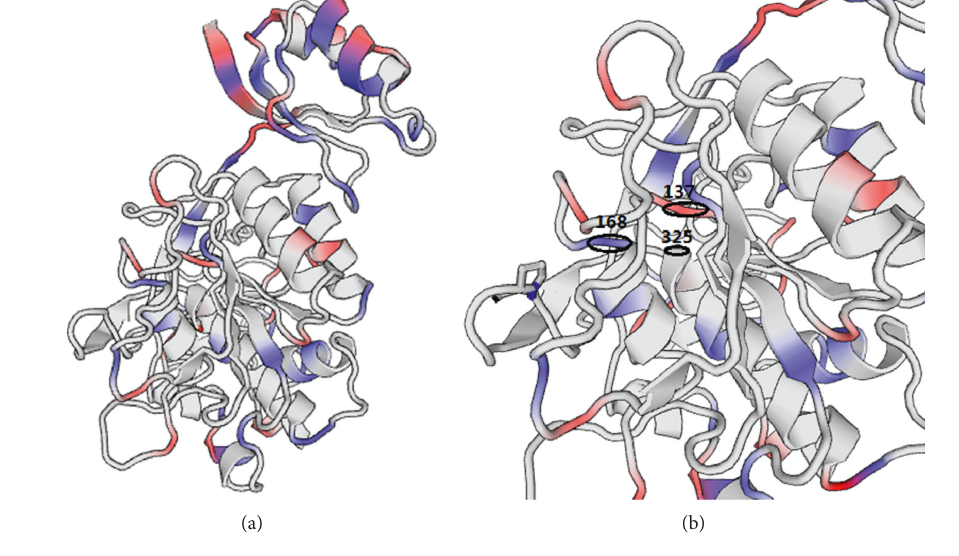
Figure 7: Active site of the Bacillus subtilis molecule.